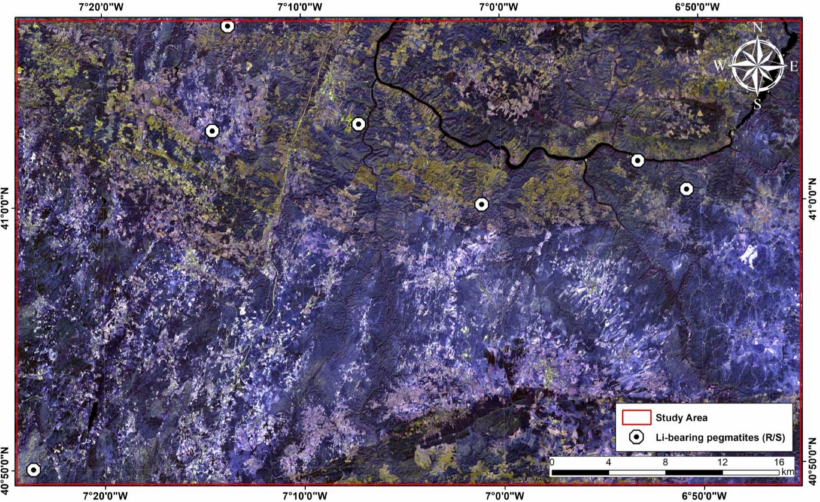
Figure 11. Result map of possible locations of Li pegmatites based only on remote sensing